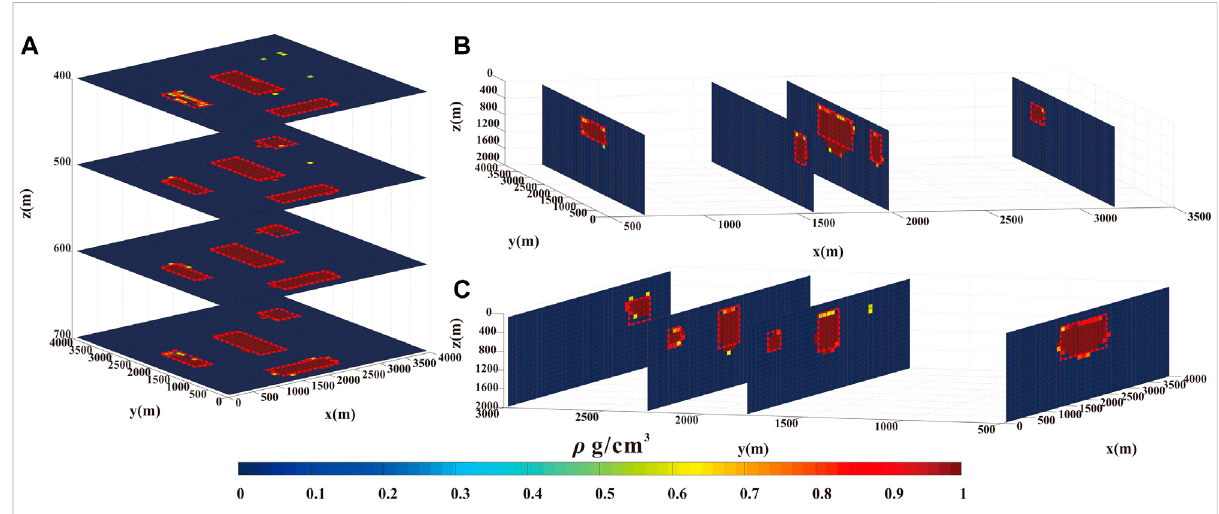
FIGURE 3 (A) the plan section of the recovered density model obtained via the inversion of the gravity anomaly at z = -400 m, -500 m, -600 m, and -700 m (B) X-direction section of the recovered density model at x = 700 m, 1,600 m, 2000 m, and 3,200 m. (C) Y-direction section of the